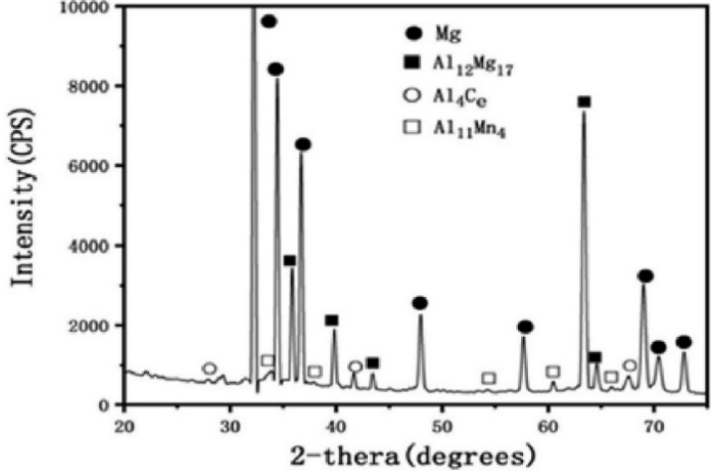
Figure 5. XRD results of rare elements based AZXX alloy